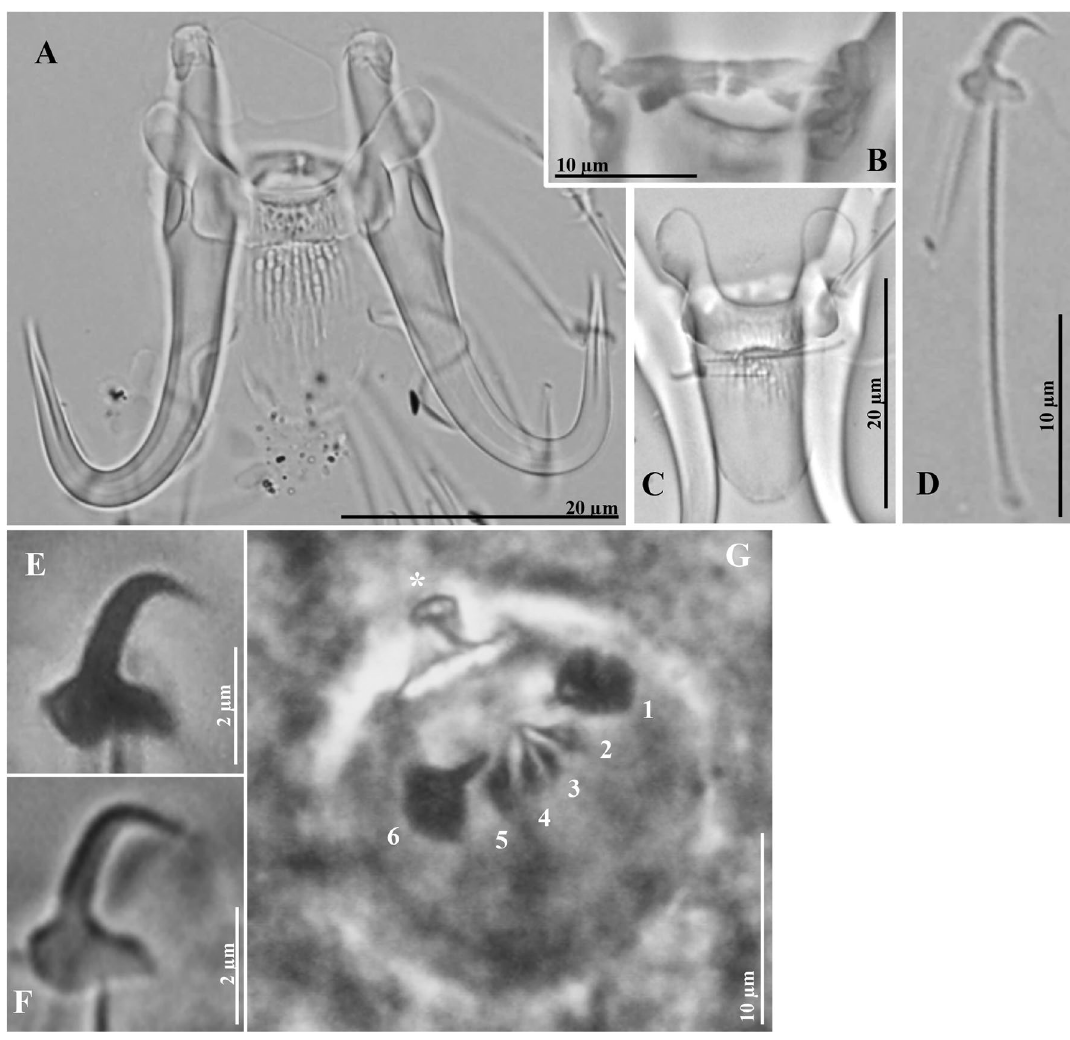
Figure 4. Micrographs of Gyrodactylus yacatli collected from Chiapas, Jalisco, Sinaloa, Oaxaca and Veracruz. ( A ) Hamuli complex. ( B ) Dorsal bar. ( C ) Ventral bar. ( D ) Marginal hook at a glance. ( E , F ) Marginal hook sickle. ( G ) Male Copulatory Organ (MCO) (star denotes principal hook and numbers denote the